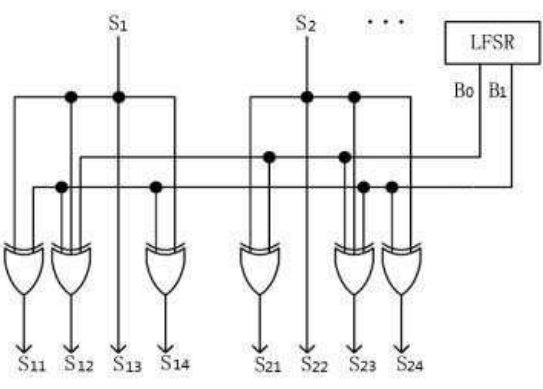
Figure 3. Broadcast